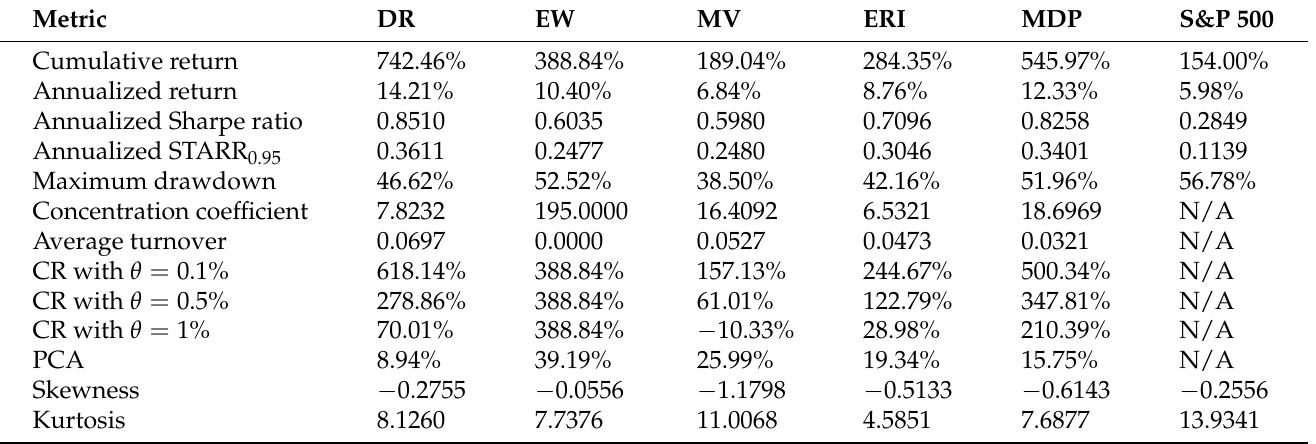
Figure A3. Portfolio values for grouped stocks with tail indices 2.5 < α ≤ 3.5. Table A2. Performance comparisons for DR, EW, MV, ERI, MDP, and S&P 500 index for stocks with 2.5 < α ≤